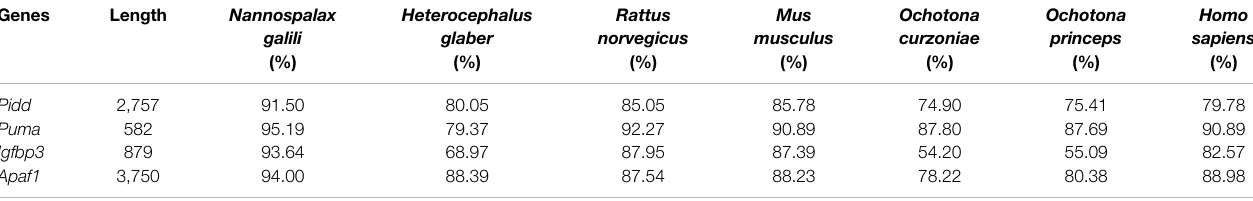
TABLE 1 | Sequence homology of apoptosis-related genes between plateau zokor and other species. Genes Length